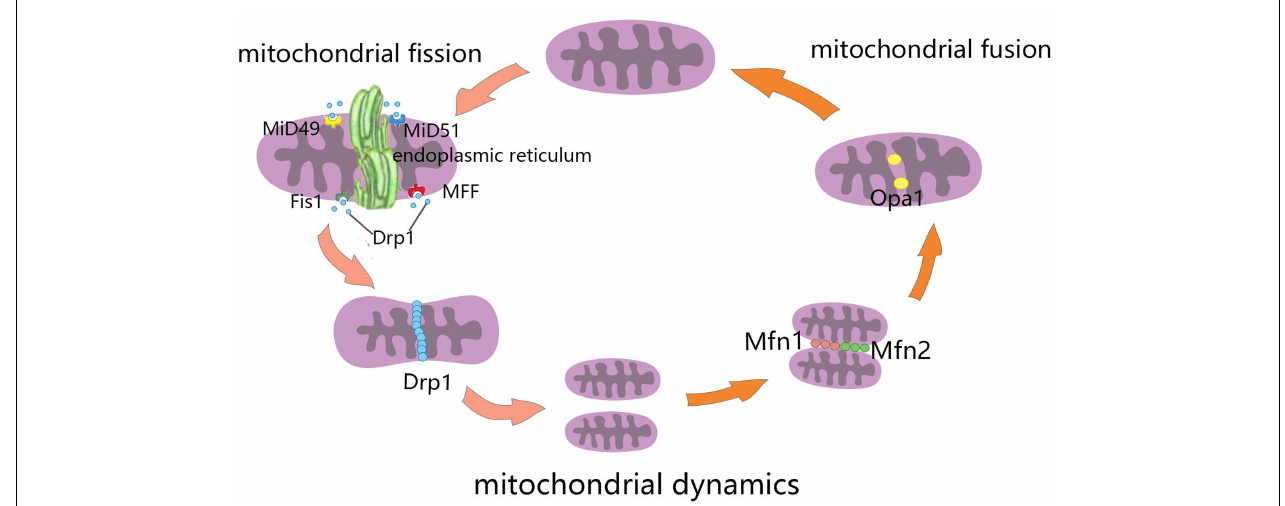
FIGURE 1 | Schematic diagram of mitochondrial dynamics. Mitochondrial fission is the division of mitochondria into two smaller mitochondria, and the dynamin-related GTPase Drp1 plays a crucial role in this process. Drp1 was recruited through four single-way transmembrane Drp1 receptors anchored on the outer mitochondrial membrane (OMM): mitochondrial fission factors (Mff), mitochondrial kinetic proteins 49 and 51(MiD49 and MiD51), and Fis1. Mitochondrial fusion refers to the merging of two mitochondria into one. Mitofusin1 (Mfn1) and mitofusin2 (Mfn2) mediate mitochondrial outer membrane fusion, and optic atrophy protein 1 (Opa1) mediates the fusion of mitochondrial inner membrane.